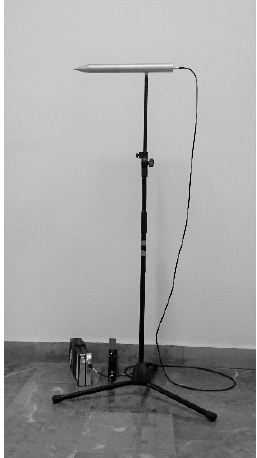
Figure 2. Measuring equipment: G.R.A.S. 67SB transducer on a tripod, bottom left, measuring the cassette of the Brüel & Kjær 3052-A-030 input module (with battery and Wi-Fi modules) and the G.R.A.S. 12AK power module.